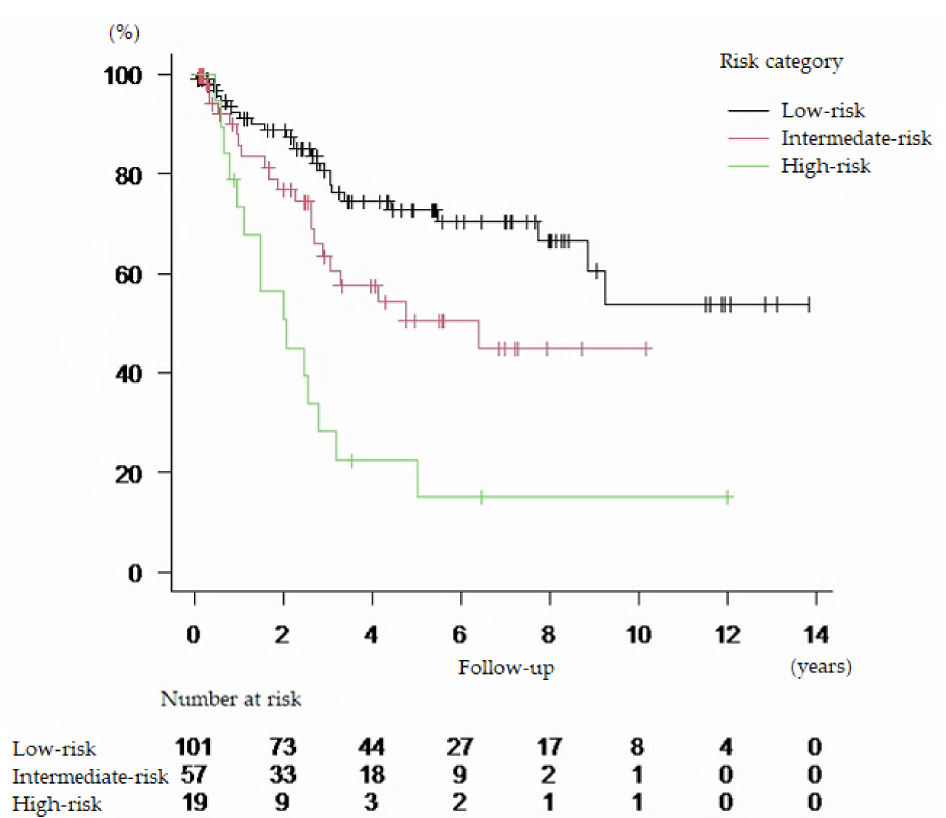
Figure 3. Kaplan–Meier curves for overall survival according to risk